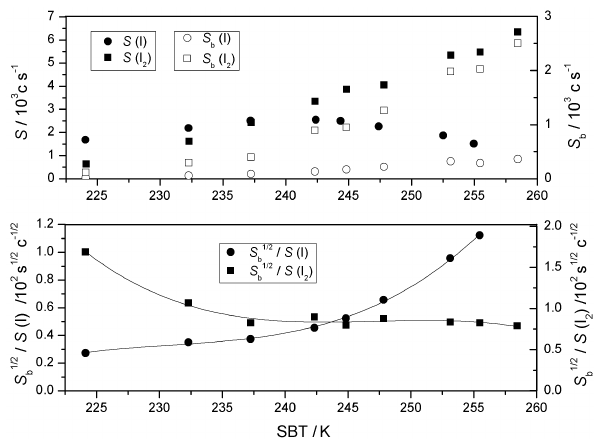
Fig. 5. Background signal dependence on SBT for the same dataset shown if Fig. 3. Top panel: fluorescence signal (filled symbols, left axis) and background signal (empty symbols, right axis) vs. SBT. Bottom panel: ratio of the squared root of the background signal to the fluorescence signal vs. SBT. Solid lines are polynomial fits to the